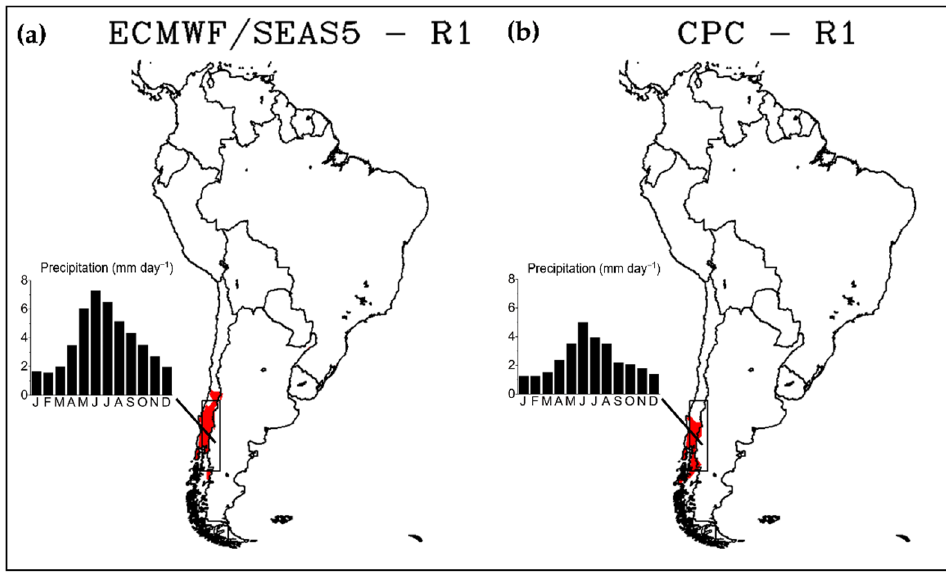
Figure 6. Region 1 (R1) was obtained by Cluster 1 and the annual precipitation cycle (mm day − 1 ) from 1993 to 2016 for ( a , b )